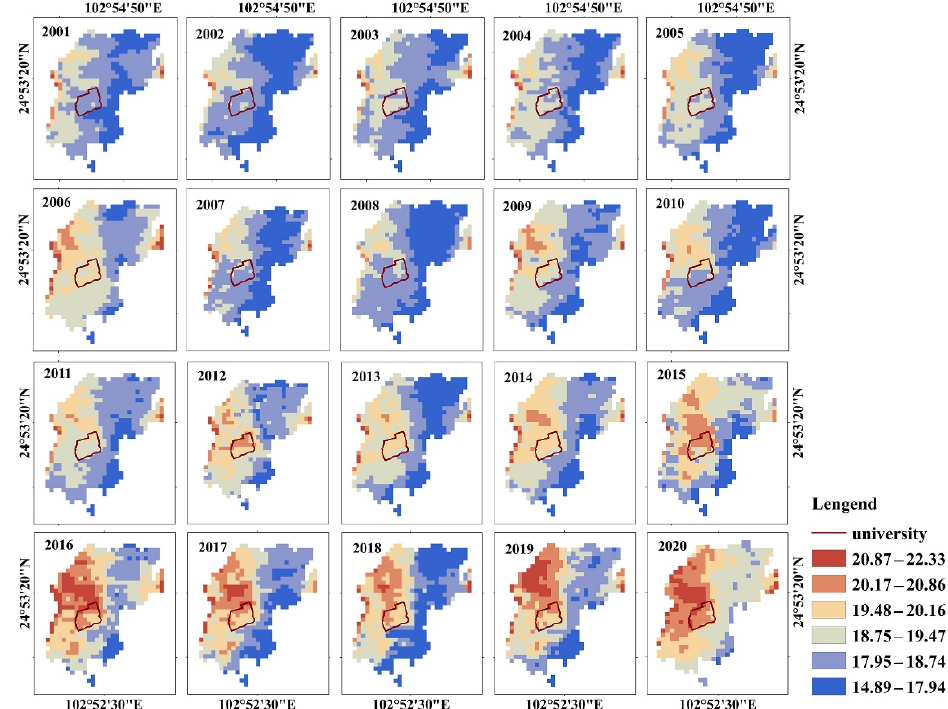
Figure 6. The spatial distribution of the annual average DI in Chenggong District from 2001 to 2020.